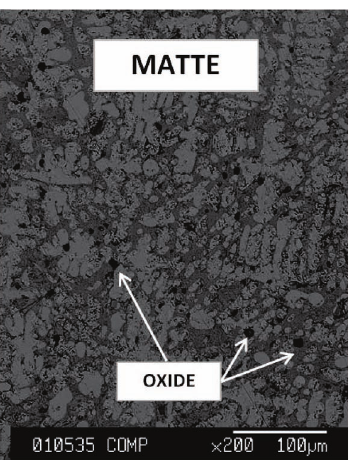
Figure 6. Suspended oxides within